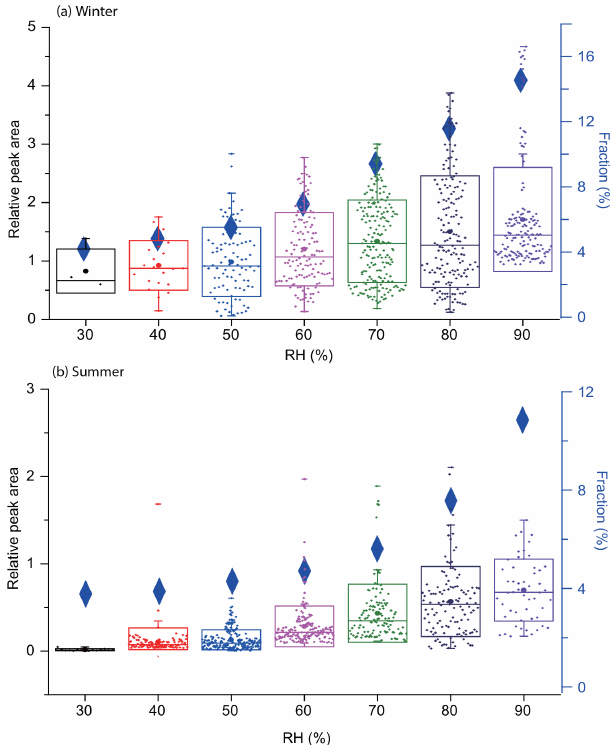
Figure 5. Box plots of the hourly relative peak area of DEA under different RH conditions in winter (a) and summer (b) . The boxes indicate the 25th and 75th percentiles; the dots indicate mean value with each data point representing a datum of RPA in an hour size bin. Right axis in each panel and the blue diamonds show the aver- age number fraction of amine-containing particles among the whole SPAMS